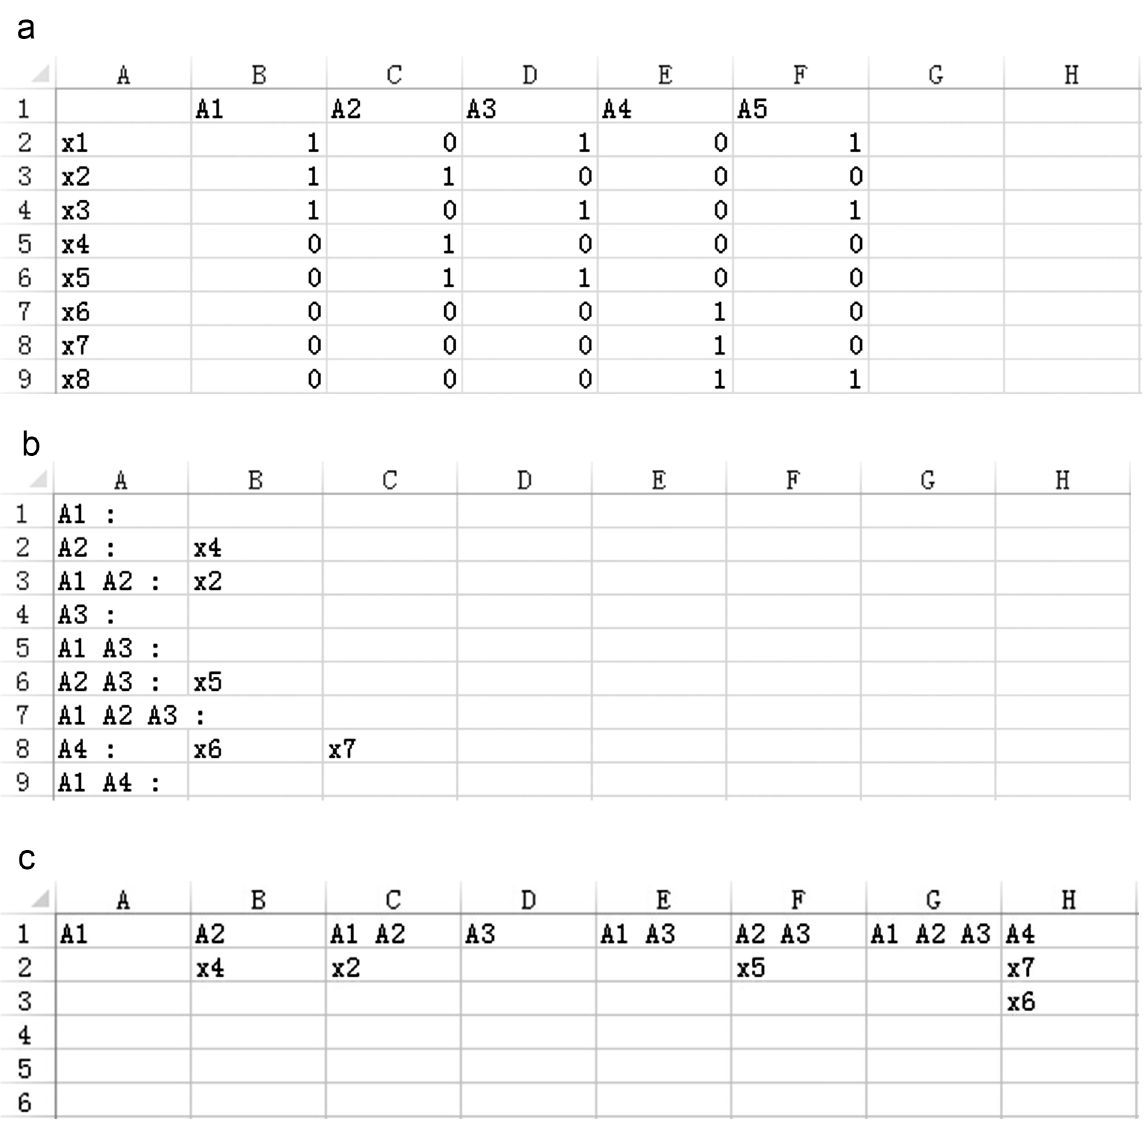
Fig 5. Output shared datasets. The Horizontal, Vertical and Matrix formats of output datasets. (a) Matrix format, first row contains all datasets and the first column contains all dataset elements; remaining columns denote if an element belongs to the dataset. Matrix used to construct a network. (b) Horizontal format, each line represents one intersection shared by datasets, which are listed before the colon. (c) Vertical format, identical to the Horizontal format with exchanged columns and